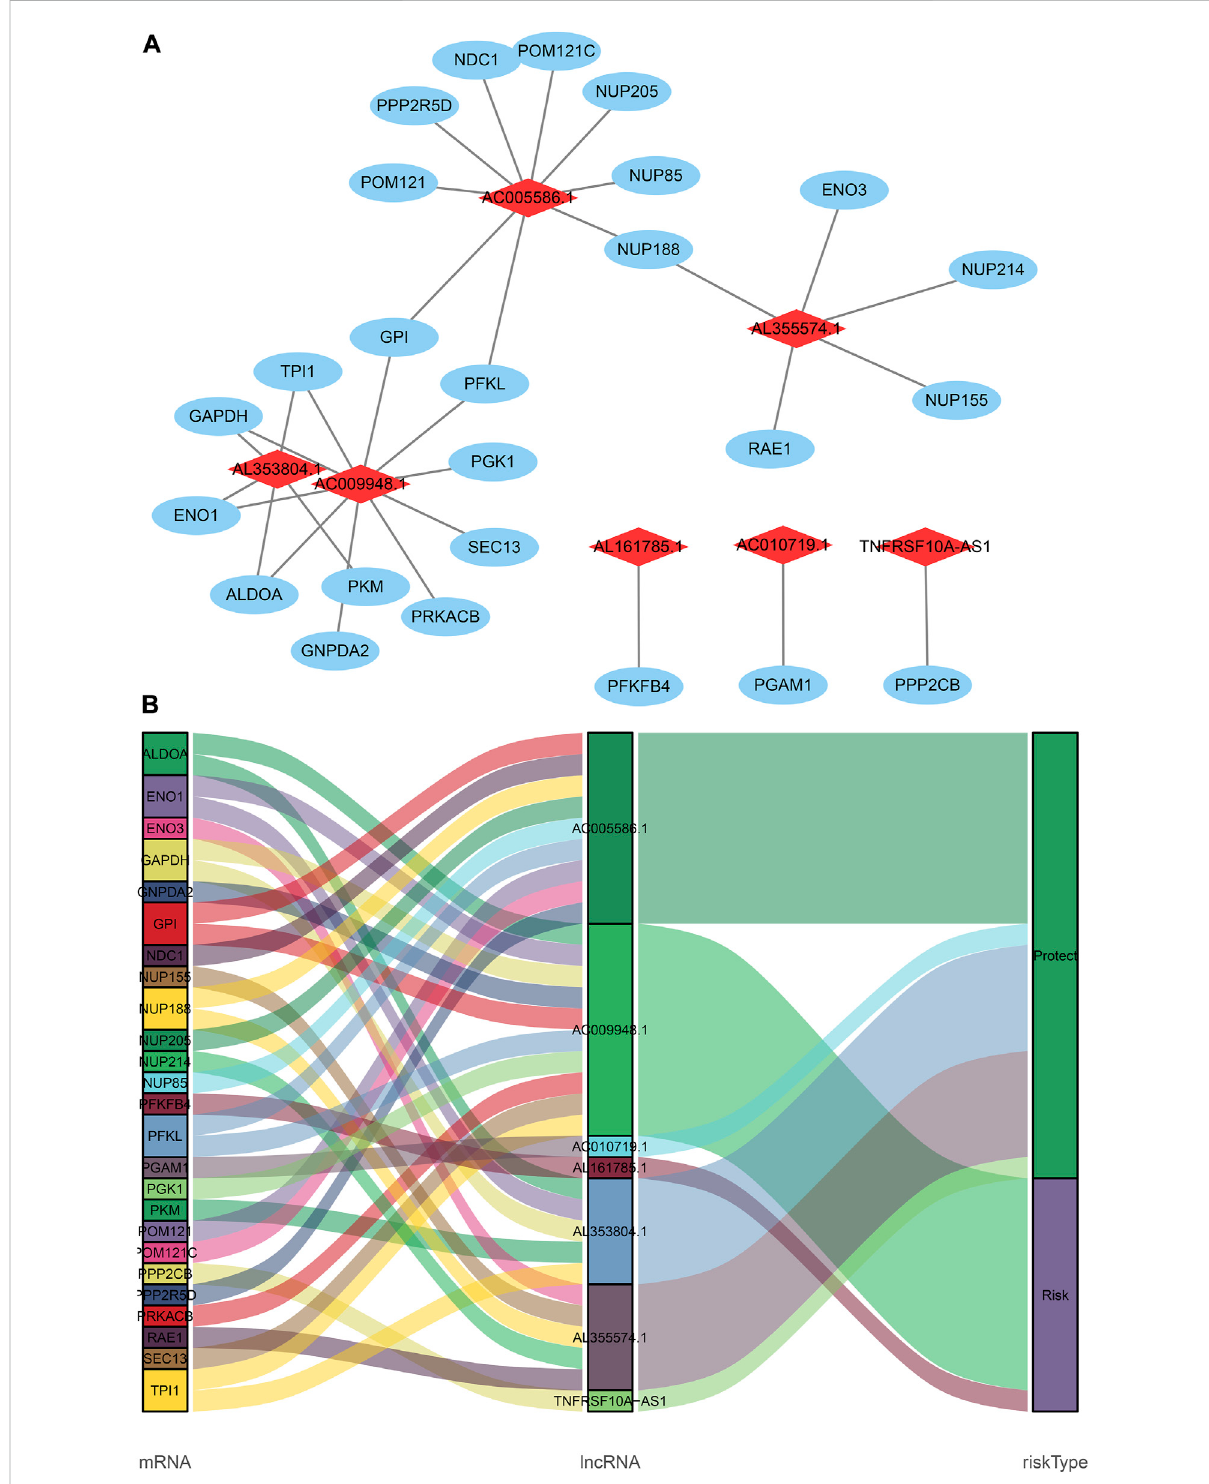
FIGURE 2 The coexpression network and Sankey diagram of prognostic glycolysis-related lncRNAs. (A) The coexpression network between prognostic glycolysis-related lncRNAs andglycolysis-relatedgenes inSTAD.Red diamond nodesrepresent prognosticglycolysis-related lncRNAs,andthesky- blue oval nodes represent glycolysis-related genes. The coexpression network was visualized using Cytoscape 3.7.1 software. (B) Sankey diagram showed the association between prognostic glycolysis-related lncRNAs, glycolysis--related genes, and risk